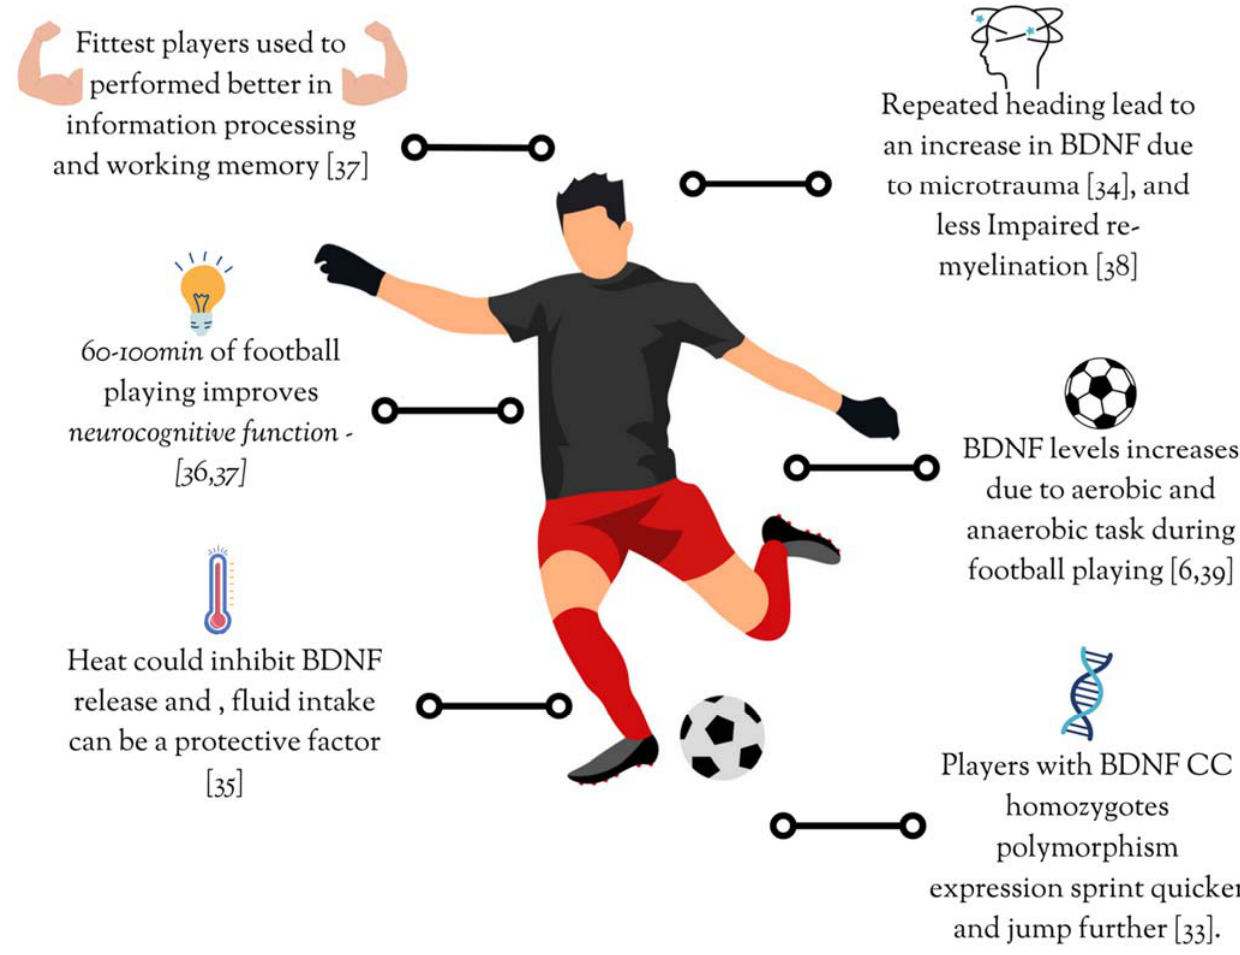
Figure 2. Main outcomes of studies analysing the effects of football playing on brain-derived neurotrophic factor levels [6,33–39].